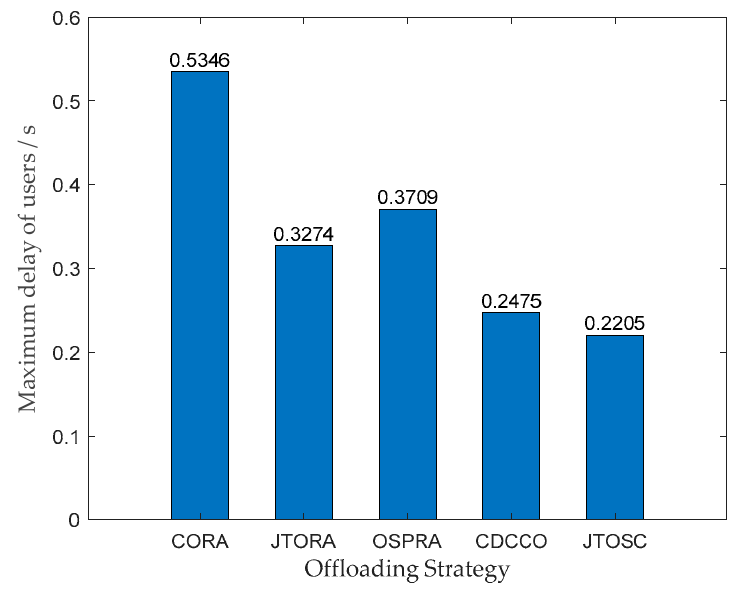
Figure 2. The maximum delay of users under different strategies. Simultaneously, the JTOSC and CDCCO strategies show better performance than the JTORA and OSPRA strategies—the reason is whether to consider the collaboration between MECs. The tasks not hit locally can be offloaded to the collaborative MECs satisfying demands preferentially rather than the remote cloud directly, which reduces the transmission delay and balances the edge load. Besides, the JTOSC and JTORA use an iteratively updated strategy based on probability in this paper to perform service caching, better than the dynamic programming cache in CDCCO and the greedy cache in OSPRA. Therefore, the JTORA strategy shows slightly better performance than the OSPRA, and the JTOSC strategy displays the most excellent